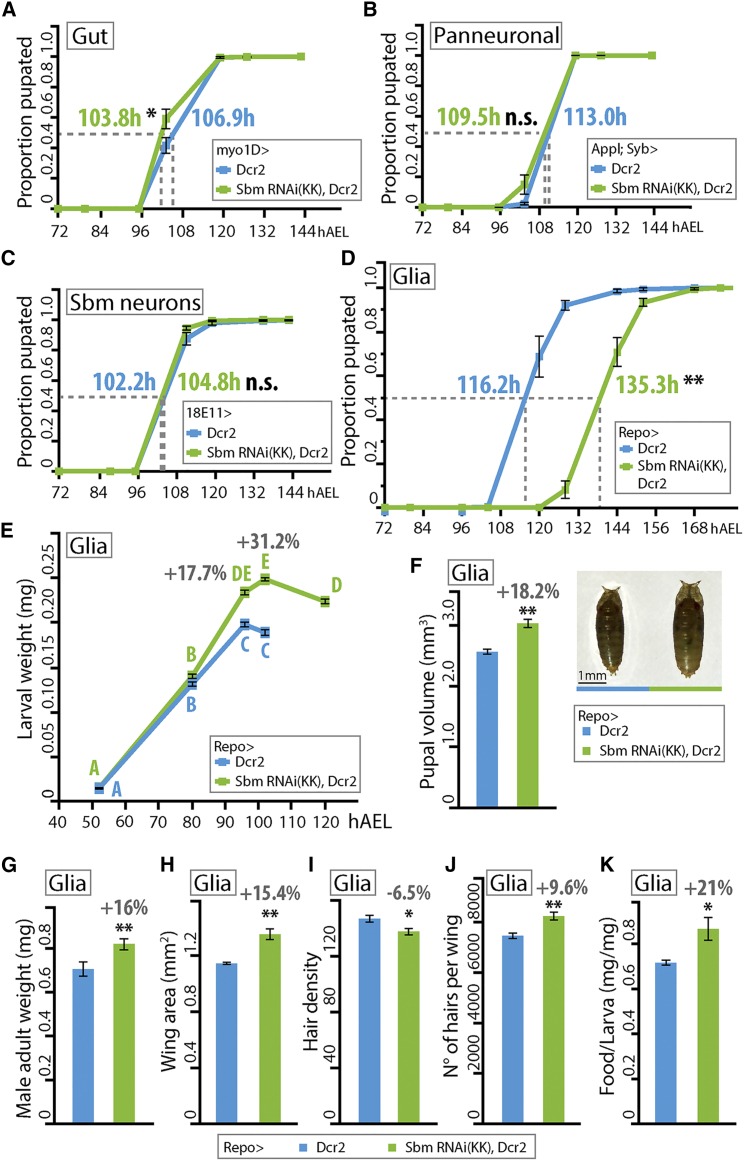
sbm Downregulation in Glia Has a Specific Effect on Developmental Timing and Growth(A–C) Proportion of larvae pupated through time after downregulation of sbm in the gut (A; myo1D-Gal4), panneuronally (B; Appl-Gal4; Syb-Gal4), and in the group of neurons that project to the corpora cardiaca (C; 18E11-Gal4). In all cases, a t test was performed, and n.s. indicates nonsignificant differences. t values are as follows: t = 2.56 (A, n = 8), t = 1.95 (B, n = 9), and t = 1.79 (C, n = 5).(D–K) Downregulation of sbm in glia (via expression of the RNAi with Repo-Gal4) leads to a delay to pupation, an increase in final size, and an increase in feeding.(D) Proportion of larvae pupated through time (t test, t = 8.07; ∗∗p < 0.0001; n = 15).(E) Larval weight (in milligrams) at different time points through development (two-way ANOVA; data were transformed to natural logarithm [ln] to fulfill the test criteria; p < 0.0001, F = 18.99; points with different letters signify that they are significantly different with p < 0.05 in a Tukey post-test; n = 15–22 per age and genotype).(F) Estimated pupal volume (in cubic centimeters) (t test, t = 6.09; ∗∗p < 0.0001; n = 15). The picture on the right shows example individuals of each genotype.(G) Adult male fly weight (mg) (t test, t = 7.32; ∗∗p < 0.0001; n = 36–65).(H) Male fly wing area (mm2) (t test, t = 5.51; ∗∗p < 0.01; n = 3).(I) Hair density on male fly wings (t test, t = 2.63; ∗p < 0.05; n = 3).(J) Estimated total number of hairs per male wing (t test, t = 4.03; ∗∗p < 0.01; n = 3).(K) Amount of food (mg) ingested by 22-hr-old synchronized third-instar larvae normalized by their mass (mg) (t test, t = 3.28; ∗p < 0.05; n = 5).In all graphs, data represent mean ± SEM, and the percentages above the bars indicate the difference in respect to the control. hAEL, hours after egg laying.